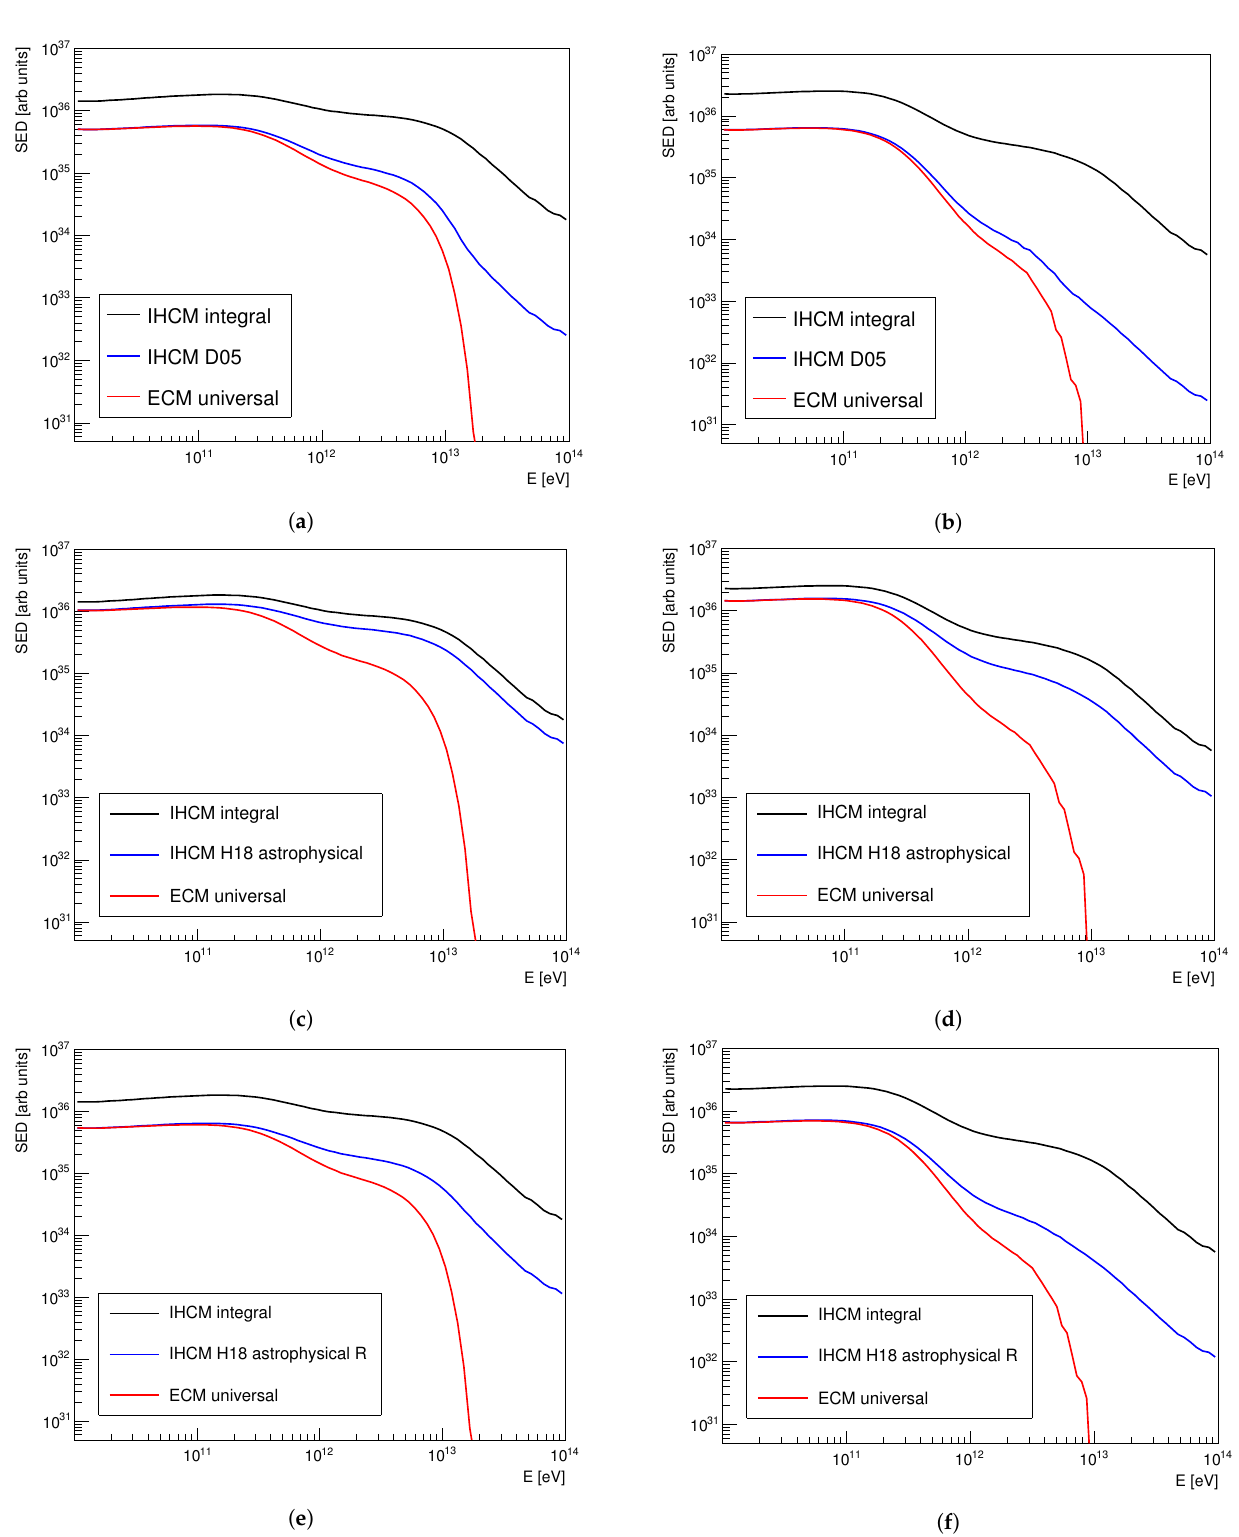
Figure 1. Observable Spectral Energy Distributions (SEDs) for intergalactic cascade models. Blue curves denote the SEDs in the framework of the Intergalactic Hadronic Cascade Model (IHCM) inside the Point Spread Function (PSF) of 0.1 ◦ . Black curves denote the integral SEDs or SEDs for the basic hadronic cascade model (i.e., SEDs, for which no cuts on the observable angles have been applied). Red curves denote the universal spectra in the framework of the Electromagnetic Cascade Model (ECM). ( a , c , e ) demonstrate the results for the source 1ES 0229+200 ( z = 0.14) and D05, astrophysical (H18), and astrophysicalR (H18) models of Extragalactic Magnetic Field (EGMF) respectively; ( b , d , f )—for the source 1ES 0414+009 ( z = 0.287) and D05, astrophysical (H18), and astrophysical R (H18) models of EGMF